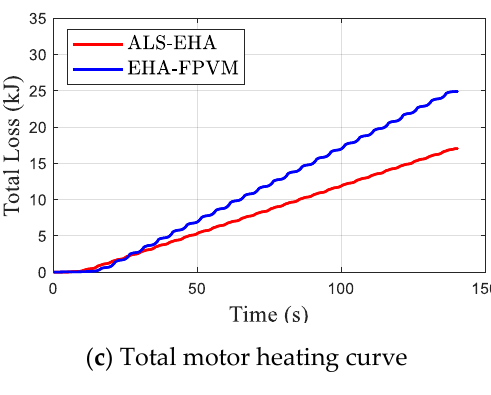
Figure 19. Motor heating curve.